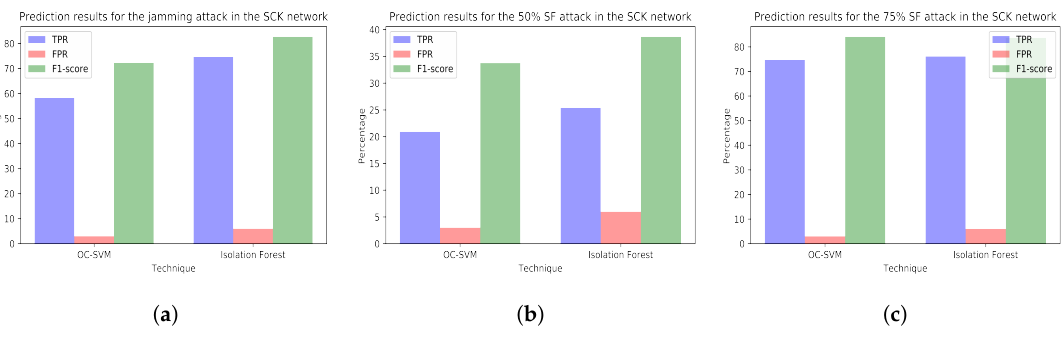
Figure 12. ( a ) prediction results for the jamming attack period using the variables from the SCK network (training with dataset tr_sck and test with dataset te_sck_jam ); ( b ) prediction results for the 50% selective forwarding attack period using the variables from the SCK network (training with dataset tr_sck and test with dataset te_sck_sf50 ); ( c ) prediction results for the 75% selective forwarding attack period using the variables from the SCK network (training with dataset tr_sck and test with dataset te_sck_sf75